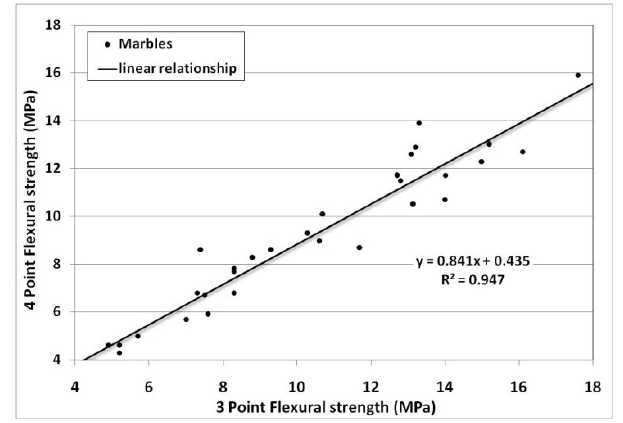
Figure 5. Relationship between FS 3 and FS 4